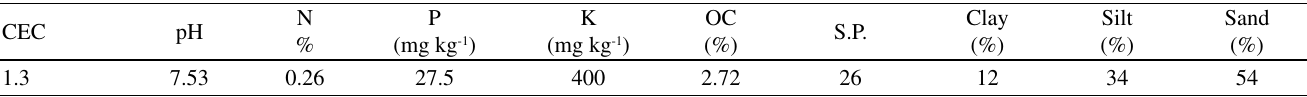
Table 1 - Some physical, chemical and nutritional characteristics of the soil used in the study CEC